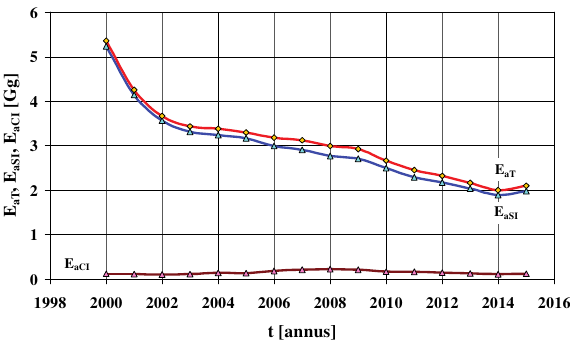
Fig. 8. National annual emission of methane from passenger cars